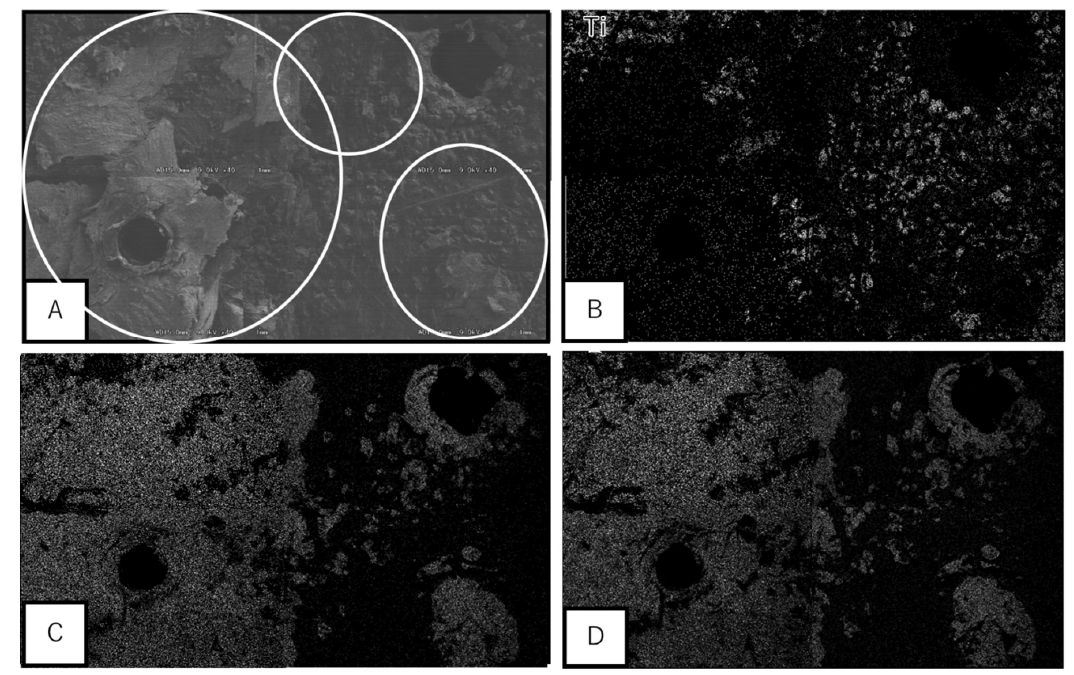
Figure 5. Electron micrograph by energy dispersive X-ray mapping. White circles indicate the area of bone tissue. ( A ): Backscattered electron image, ( B ): Titanium, ( C ): The area of calcium, ( D ): The area of phosphorus. Materials 2020 , 13 , x FOR PEER REVIEW